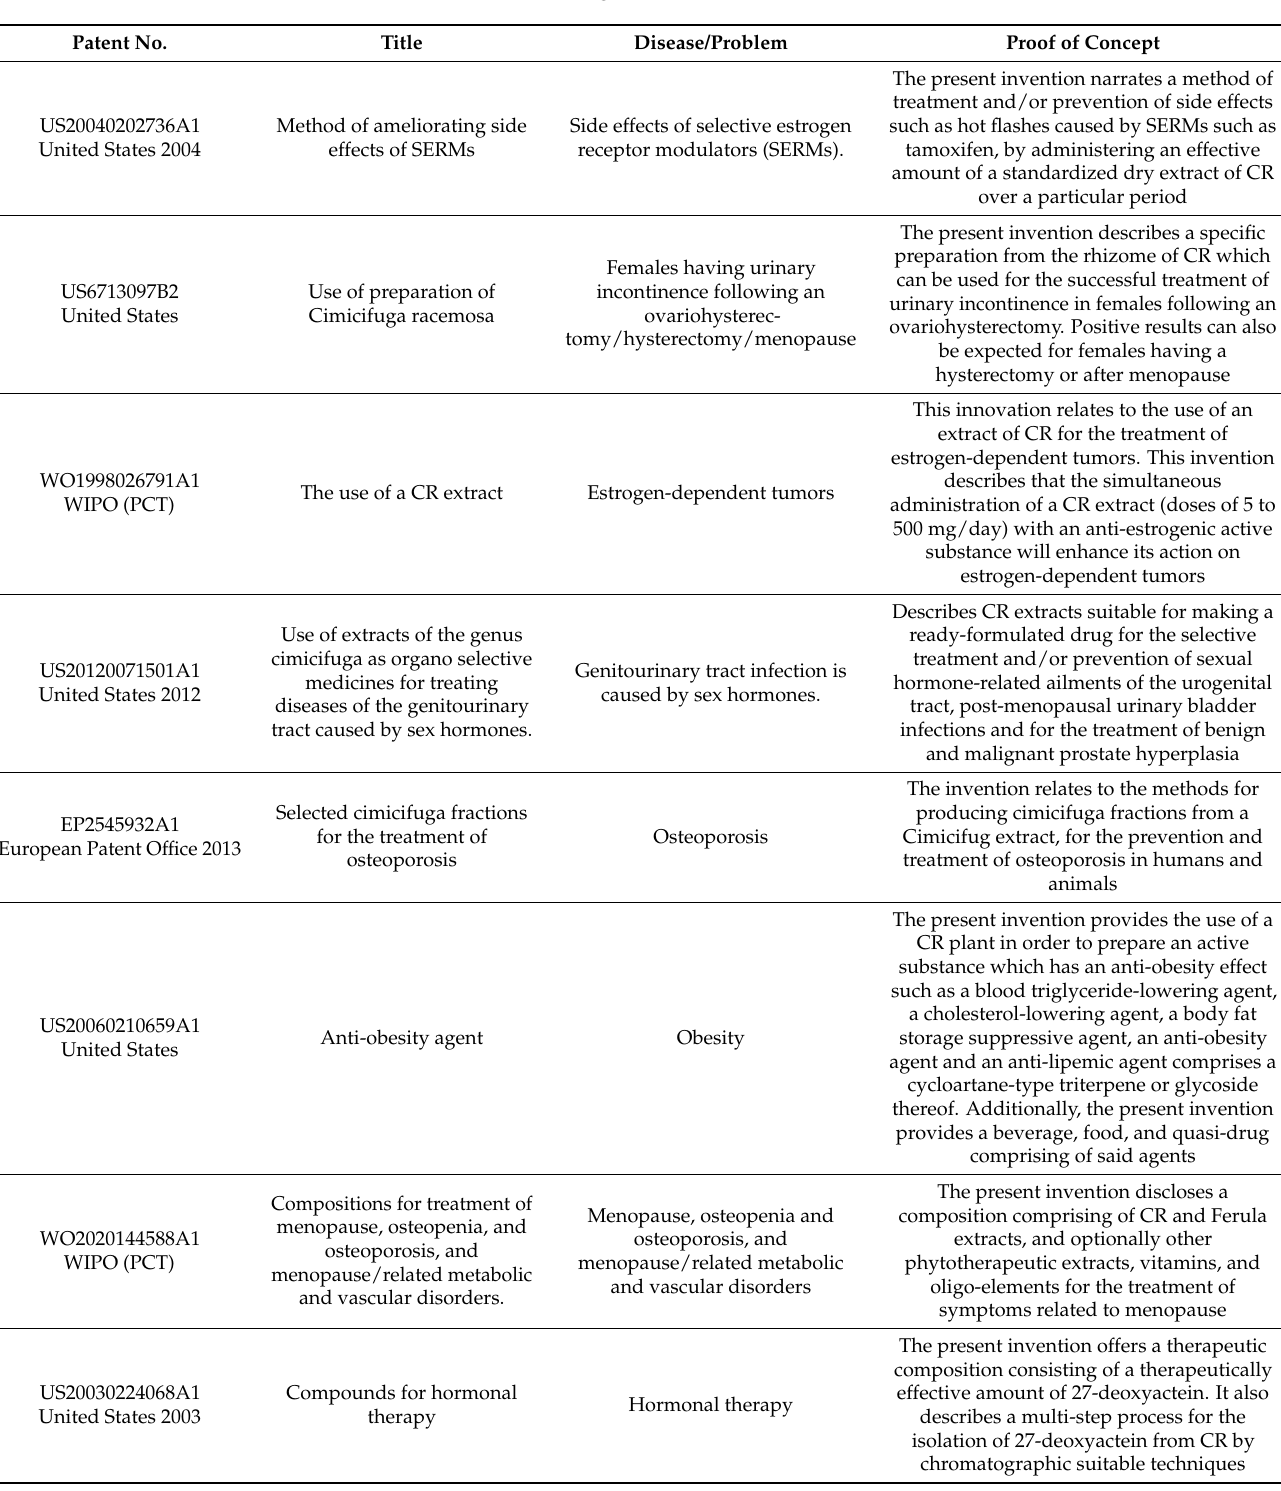
Table 7. Patents of CR relating to women’s